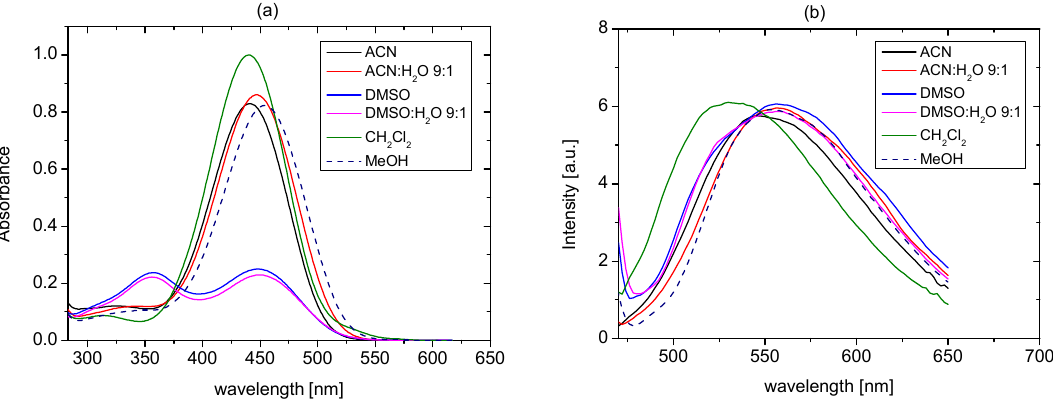
Figure 14. ( a ) UV-Vis absorption and ( b ) emission spectra of t -Bu-19- p -OH (2.6 × 10 − 5 M) in solvents of various properties. of various